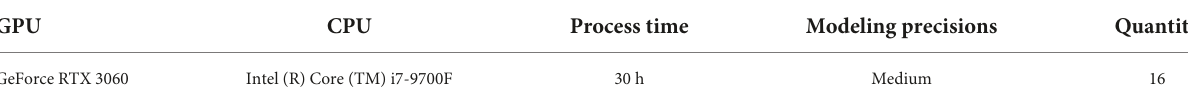
TABLE 1 Modeling hardware information.